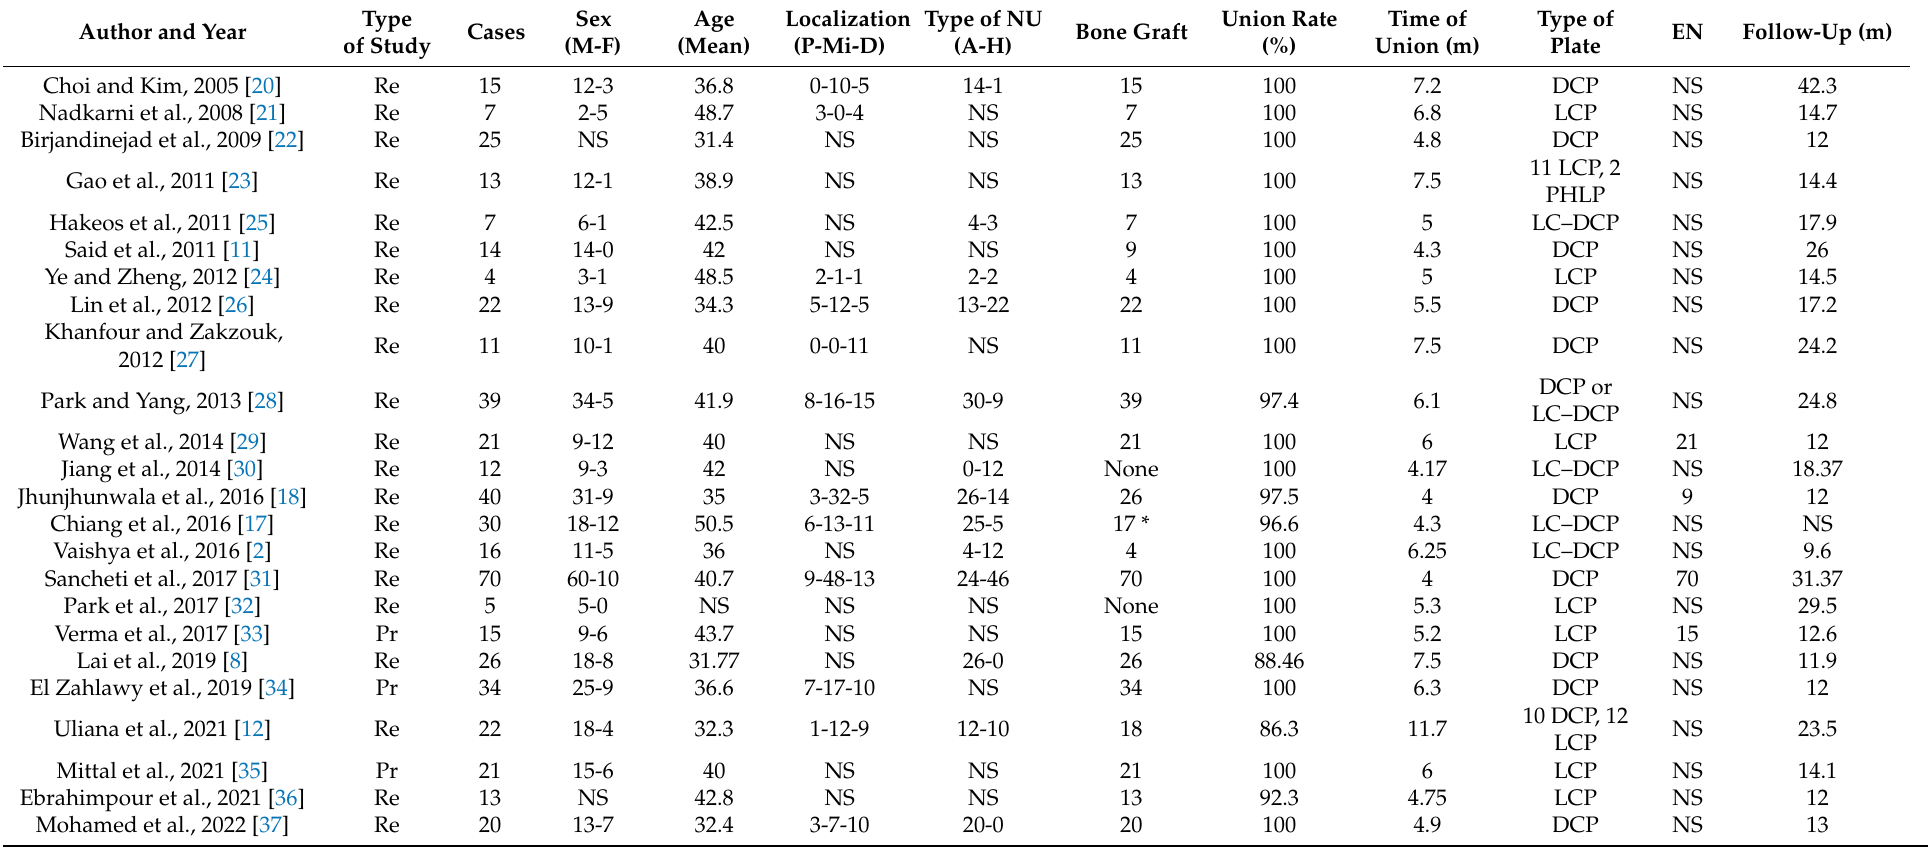
Table 1. Studies included in the review and main